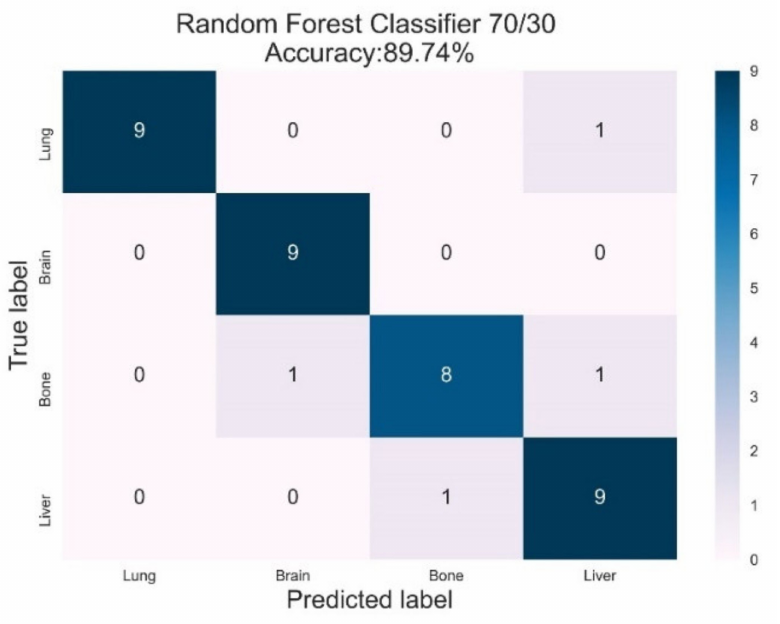
Figure 17. Confusion Matrix (Random Forest Classifier).